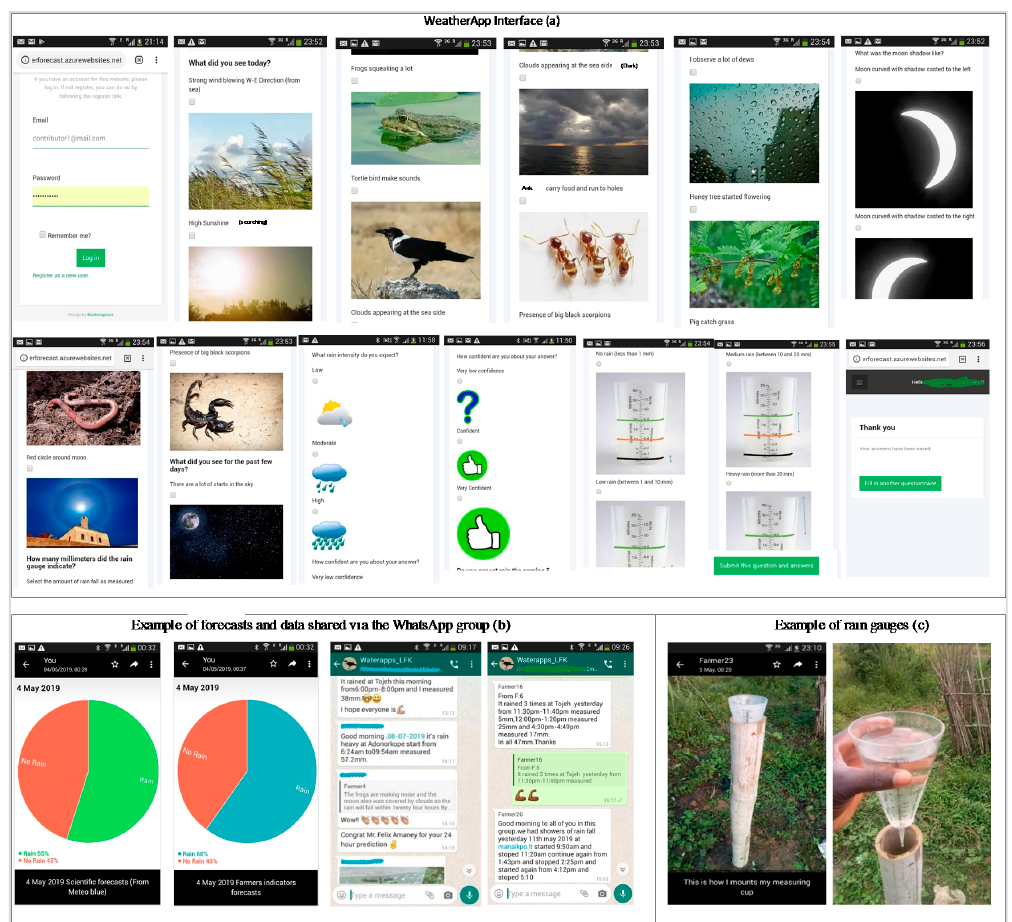
Figure 5. The mobile applications and rain gauges used during the coproduction experiment. These included ( a ) a weather app used by farmers to collect real-time data on local forecast indicators and rainfall (see Table 2), ( b ) a WhatsApp group used by participants to share data on rainfall, as well as to disseminate both local and scientific forecasts in simple pie chart format and also to interact (see Table 2), and ( c ) manual rain gauges used by farmers to record rainfall amounts (see Table